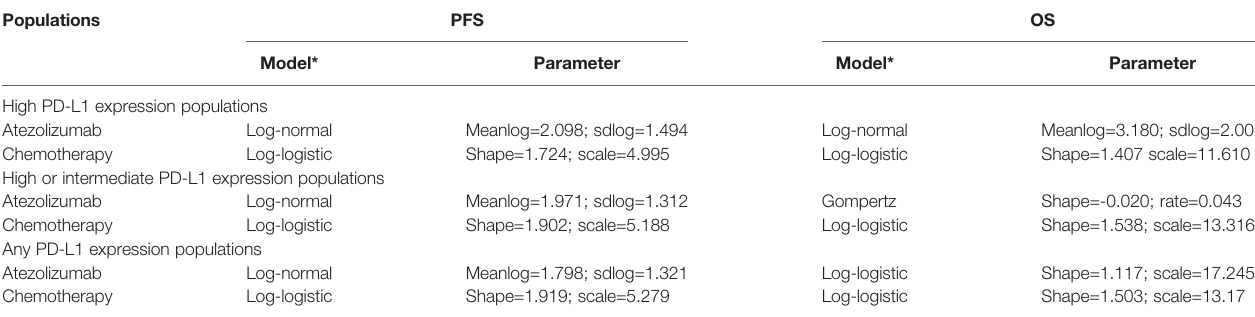
TABLE 1 | Survival model parameters fi tting to the PFS and OS data from IMpower110